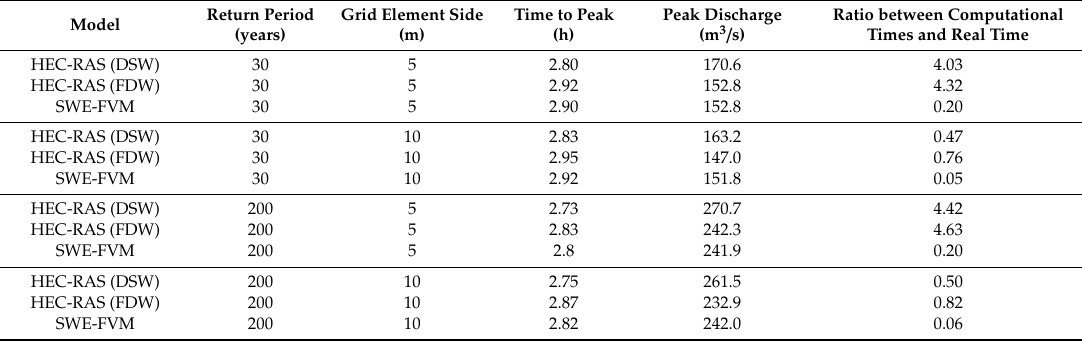
Table 2. Information related to discharge hydrographs computed at the outlet and overall computational times of the models as a function of the return period and grid element side.